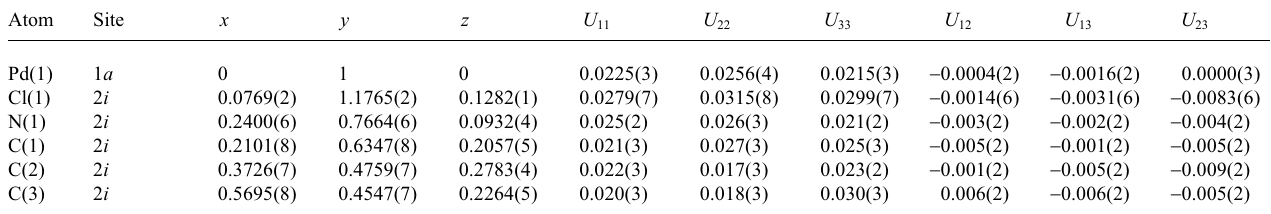
Table 3. Atomic coordinates and displacement parameters (in Å 2